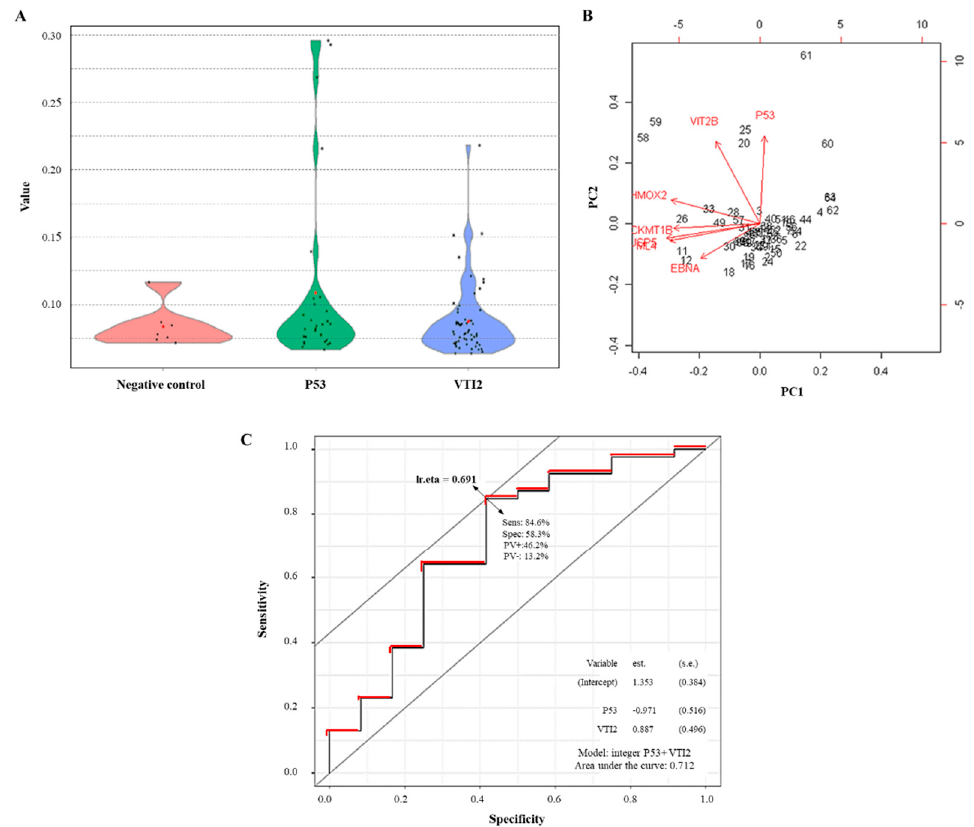
Figure 7. Validation of potential TAAs candidates in metastatic vs. non-metastatic sCRC. ( A ) Results obtained by NAPPA-ELISA in the validation cohort of sCRC patients (described in Section 2). ( B ) Canonical biplot of the 8 TAAs potential biomarker panels. ( C ) ROC analysis of dataset corresponding to validation cohort of sCRC patients (described in Section 2).